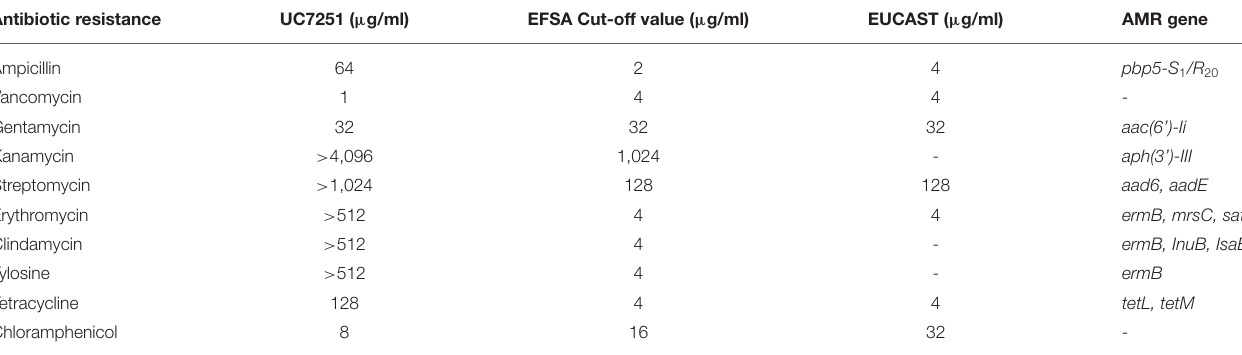
TABLE 1 | Antimicrobial resistance genes and MIC values of strain UC7251, following the guidelines and cutoff values established by EFSA/EUCAST for the safety assessment of E. faecium . Antibiotic